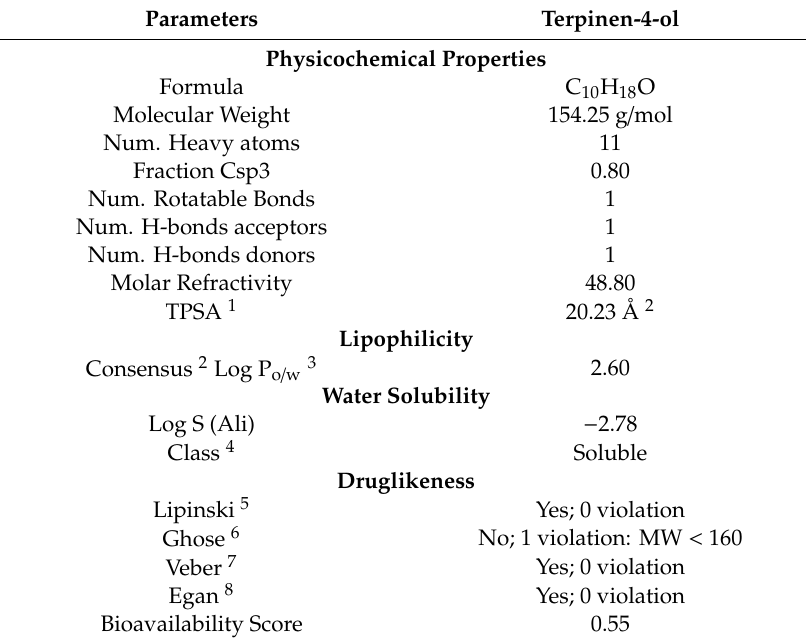
Table 4. In silico studies of Lipinski’s parameters of